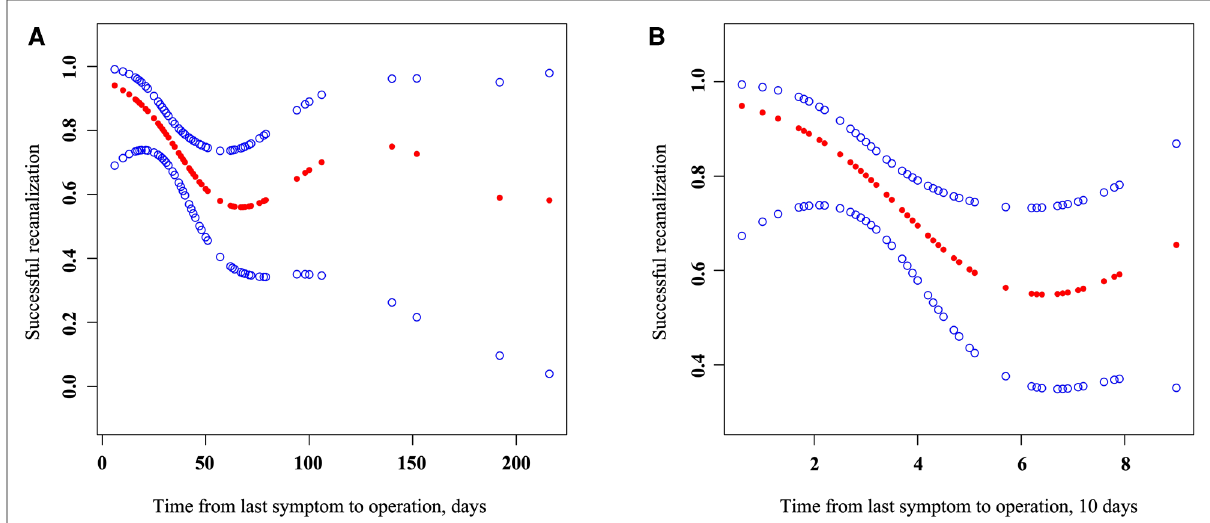
FIGURE 1 Association of the time from the last symptom to operation with successful recanalization. Smooth curve fi tting (left) of the effect of the time from the last symptom to operation (days) on successful recanalization, adjusted for age, gender, and BMI; smooth curve fi tting (right) of the eddect of the time from the last symptom to operation (10 days) on successful recanalization; parameters larger than 100 days were re fi tted in 100 days, adjusted for age, gender, and BMI.